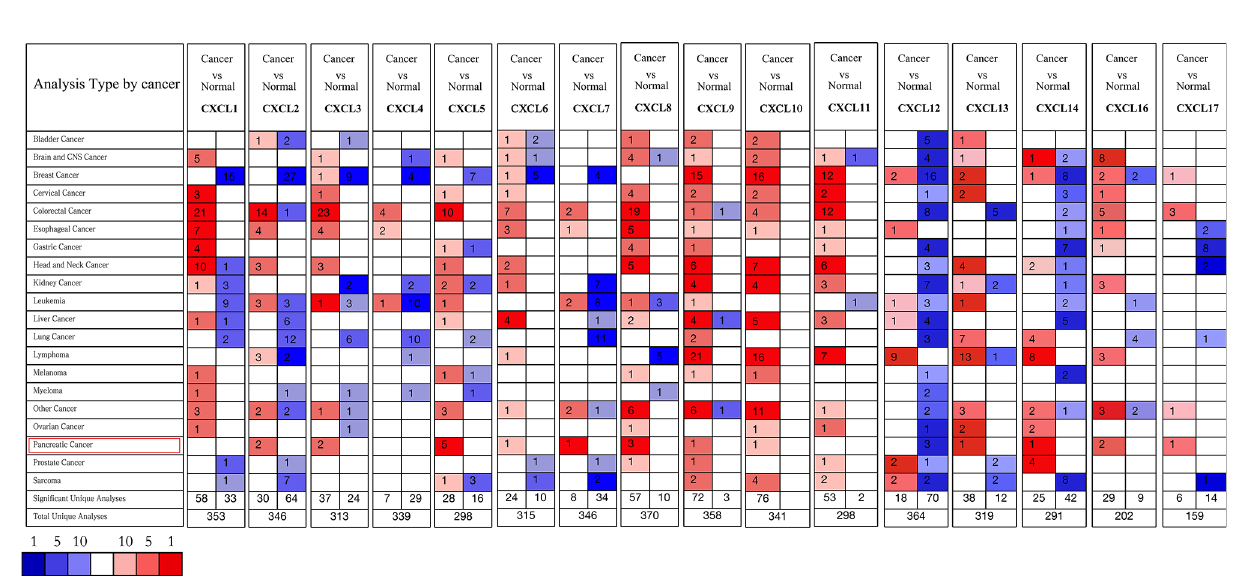
FIGURE 1 | The transcriptional levels of CXC chemokines in several human malignant tumors (ONCOMINE). Upregulated expression (red); downregulated expression (blue).